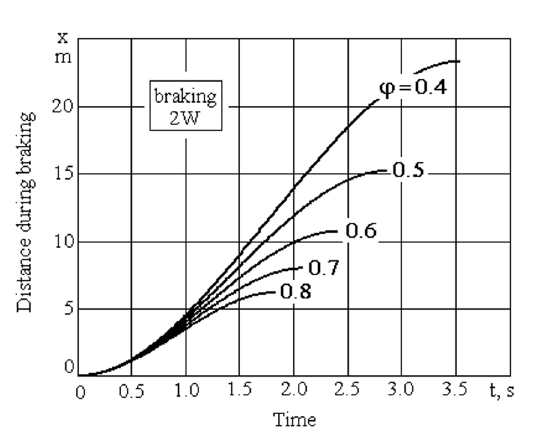
Figure 8. Maximum deceleration for the two braking systems ver- sions for different values of the coefficient of road adhe- sion.